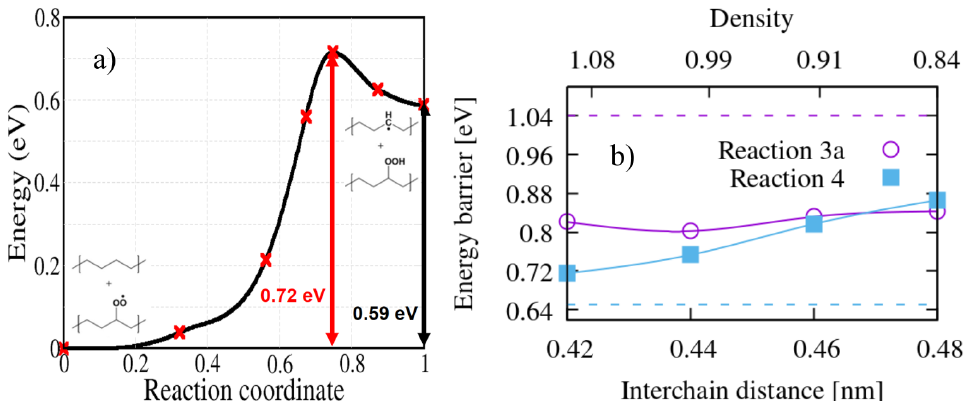
Figure 7. ( a ) The energy profile calculated for the bimolecular reaction 4 of Figure 2 as calculated in crystalline PE. ( b ) The influence of the PE interchain distance on the energy barriers of bimolecular reactions 3a and 4. The dashed lines are the energy barriers calculated for the same reactions in the lamellar interface